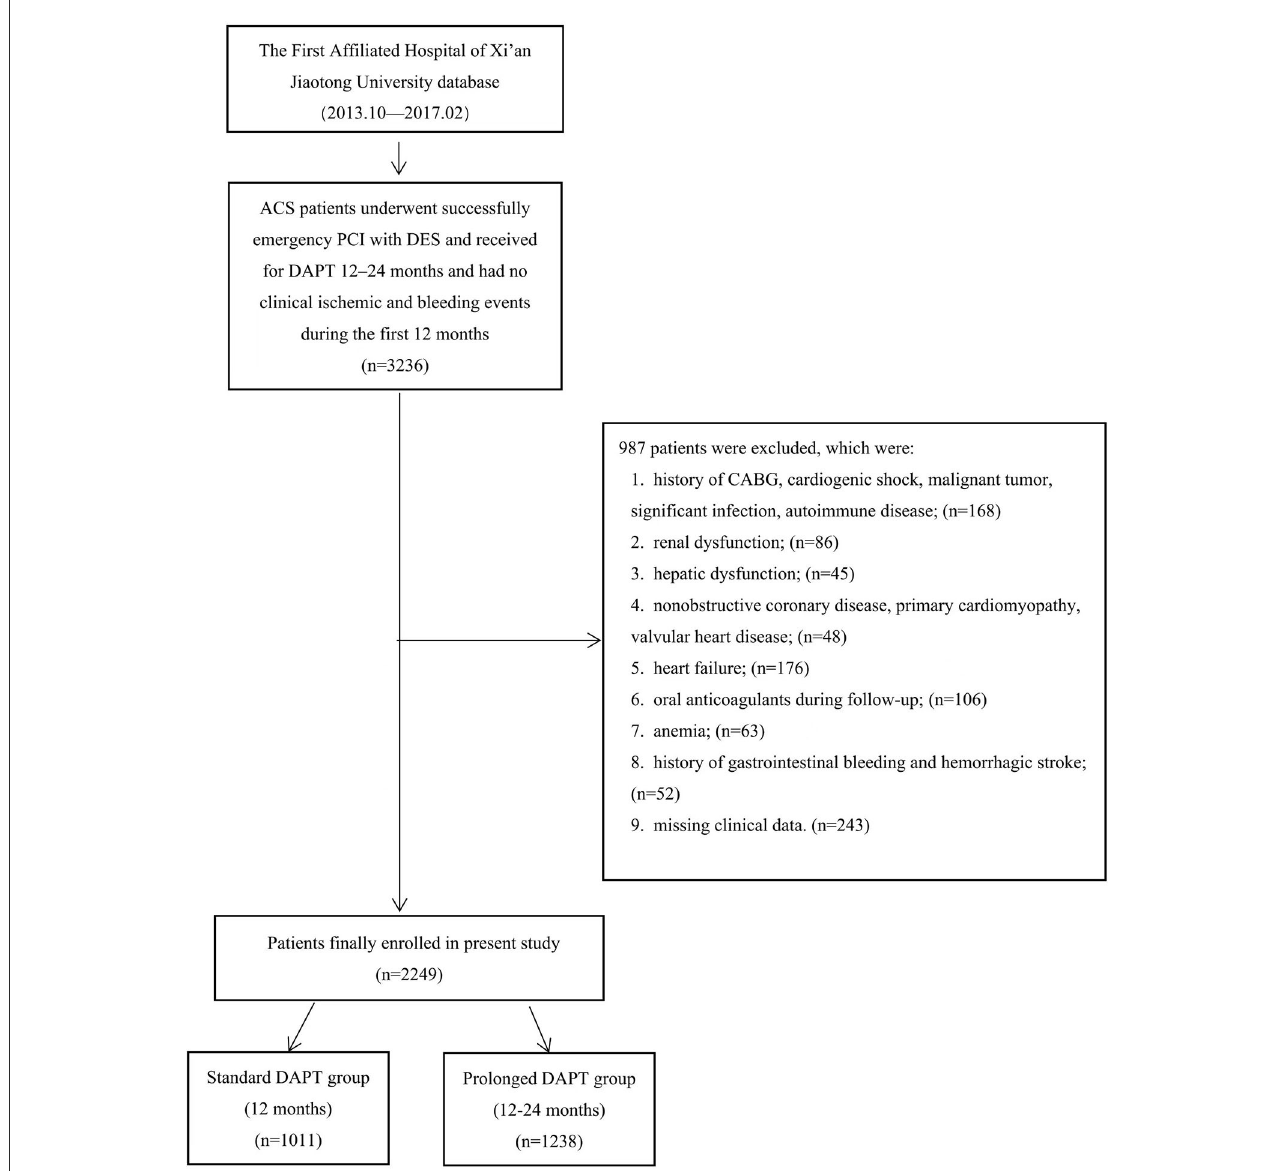
FIGURE1 The flowchart of study subject enrollment. ACS, acute coronary syndrome; PCI, percutaneous coronary intervention; DES, drug-eluting stent; CABG, coronary artery bypass grafting; DAPT, dual antiplatelet